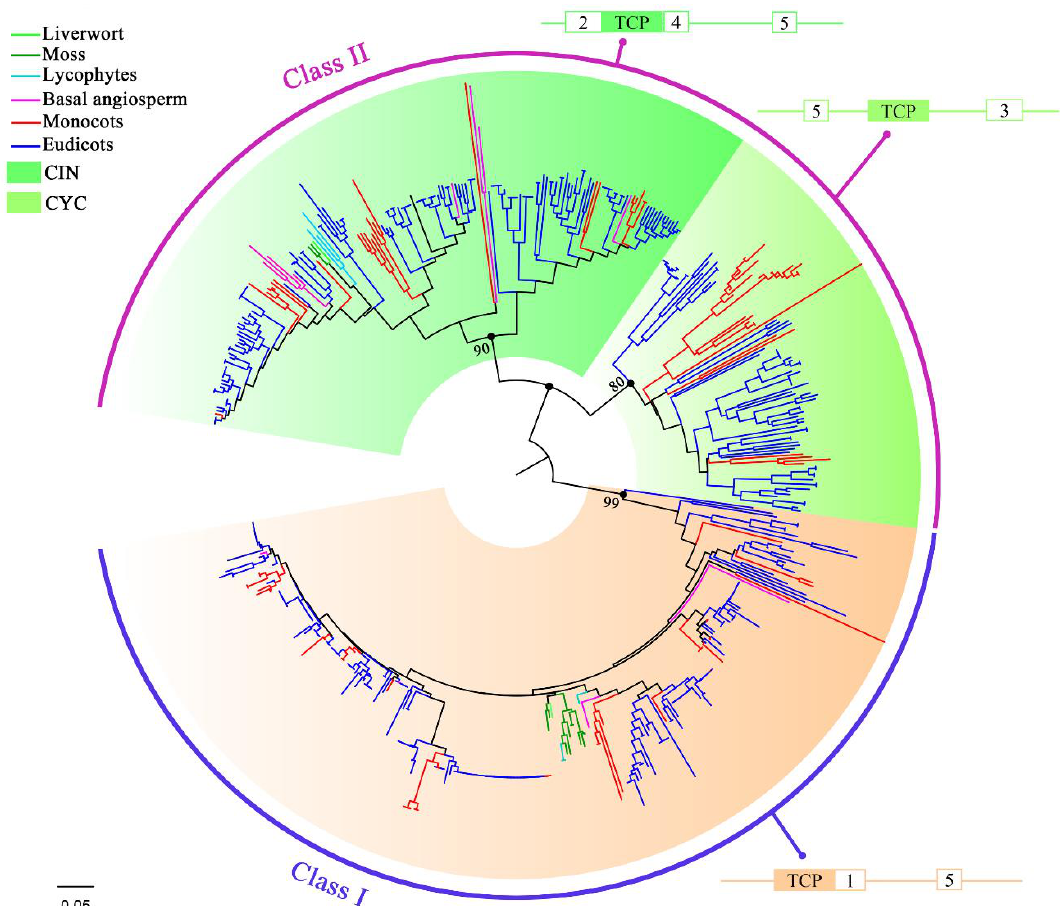
Figure 2. Neighbor joining (NJ) tree of the 535 TCP proteins clustered into Classes I and II. Class II was subdivided into clades CIN and CYC. Colored lines represent di ff erent lineages. The peripheral geometric figures indicate the motif structure predicted by MEME [35] in each class or clade.